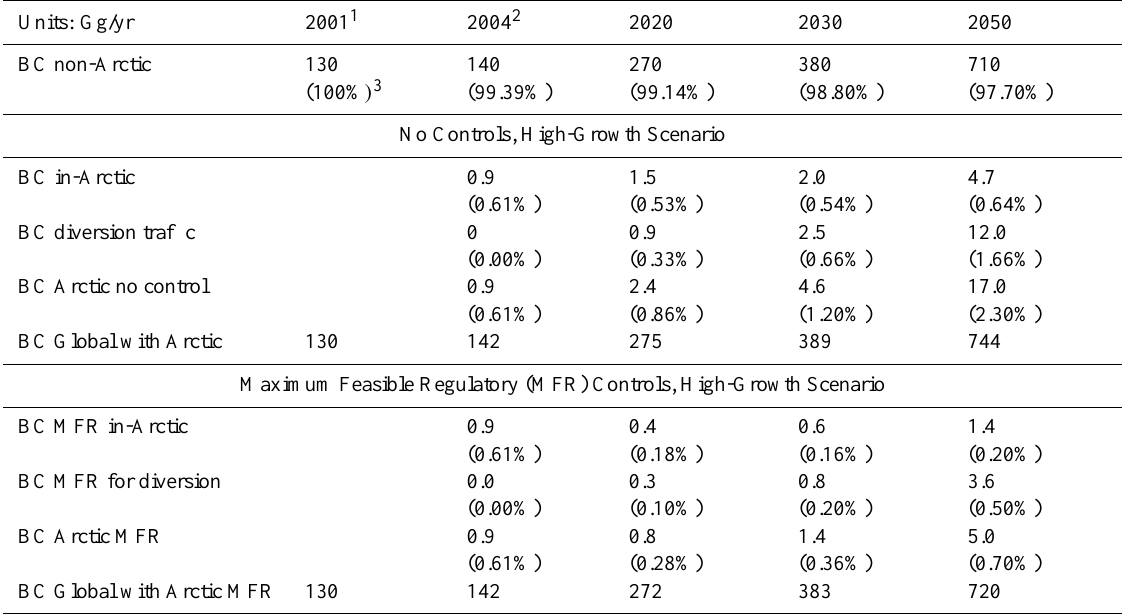
Table 13. High-growth scenarios for black carbon, with and without emissions